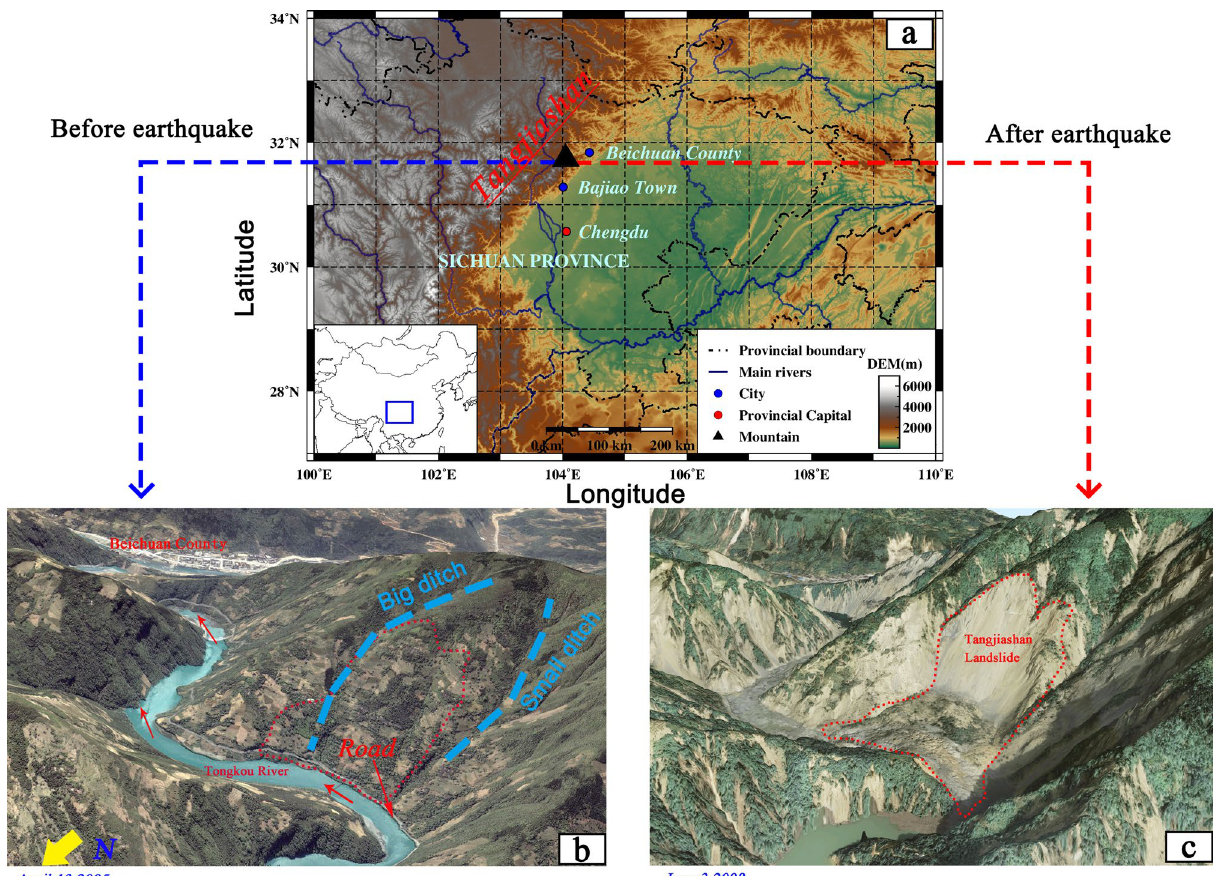
Figure 3. The digital elevation model and remote sensing model of the research zone: ( a ) location of the Tangjiashan landslide; ( b ) before the earthquake (from upstream); ( c ) after the earthquake (from upstream). The